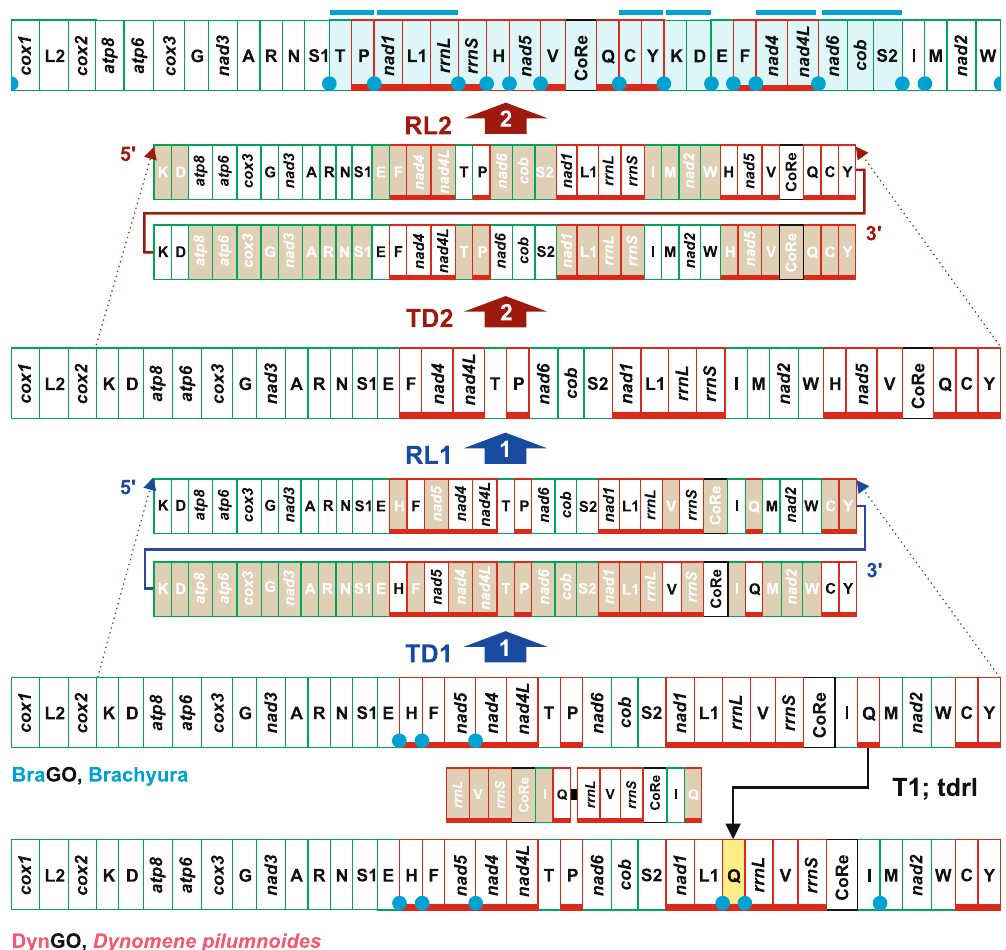
Figure 8. The evolutionary pathways producing the DynGO and MaVaGO arrangements. The rearrangements in the GOs of D . pilumnoides and Macrophthalmidae + Varunidae are investigated and depicted with respect to BraGO. T1, transposition events; tdrl, tandem duplication random loss mechanism producing the observed rearrangement. TD/RL1-2, tandem duplication/random loss events. The genomic and genetic nomenclature, as well as the colour scheme, are the same as in Fig. 1. The genes that changed their position relative to PanGO, through a transposition event, are shown with a yellow background. The passively-shifted genes are figured with their original background. The genes involved in a repositioning, which cannot be identified unambiguously as the result of a transposition or a passive shift, are figured with a light blue background. In this latter case, the common intervals, encompassing two or more genes, shared by MaVaGO with PanGO, are highlighted with a blue bar. A blue circle marks an intergenic spacer present in a position associated to genomic